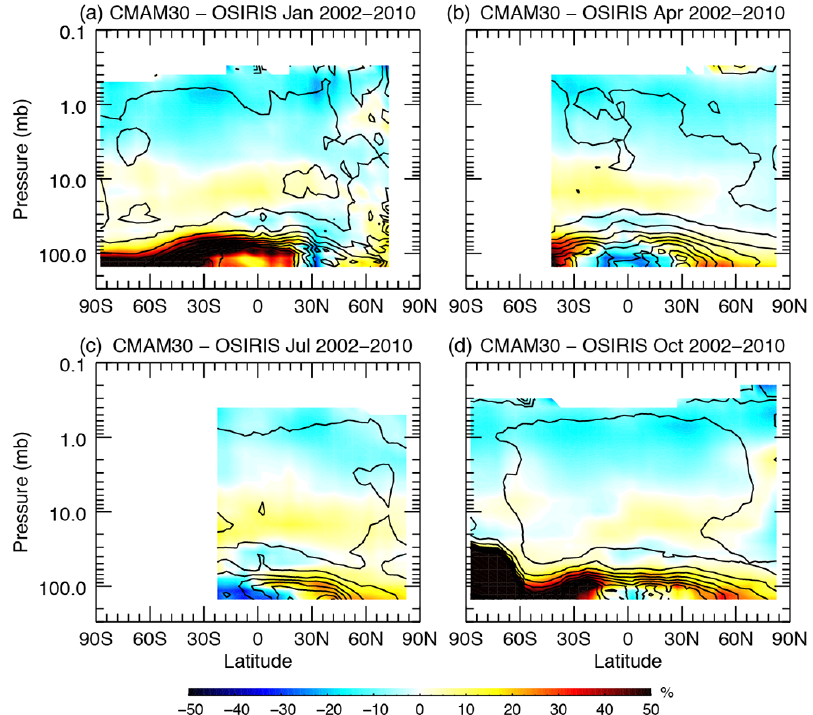
Figure 2. Same as Fig. 1 but for CMAM30 vs. OSIRIS relative differences for ozone profiles. MAD contour levels are 5%. Reds indicate where CMAM30 ozone is too high compared to OSIRIS, and blues indicate where CMAM30 ozone is low. Note that the vertical axis here is